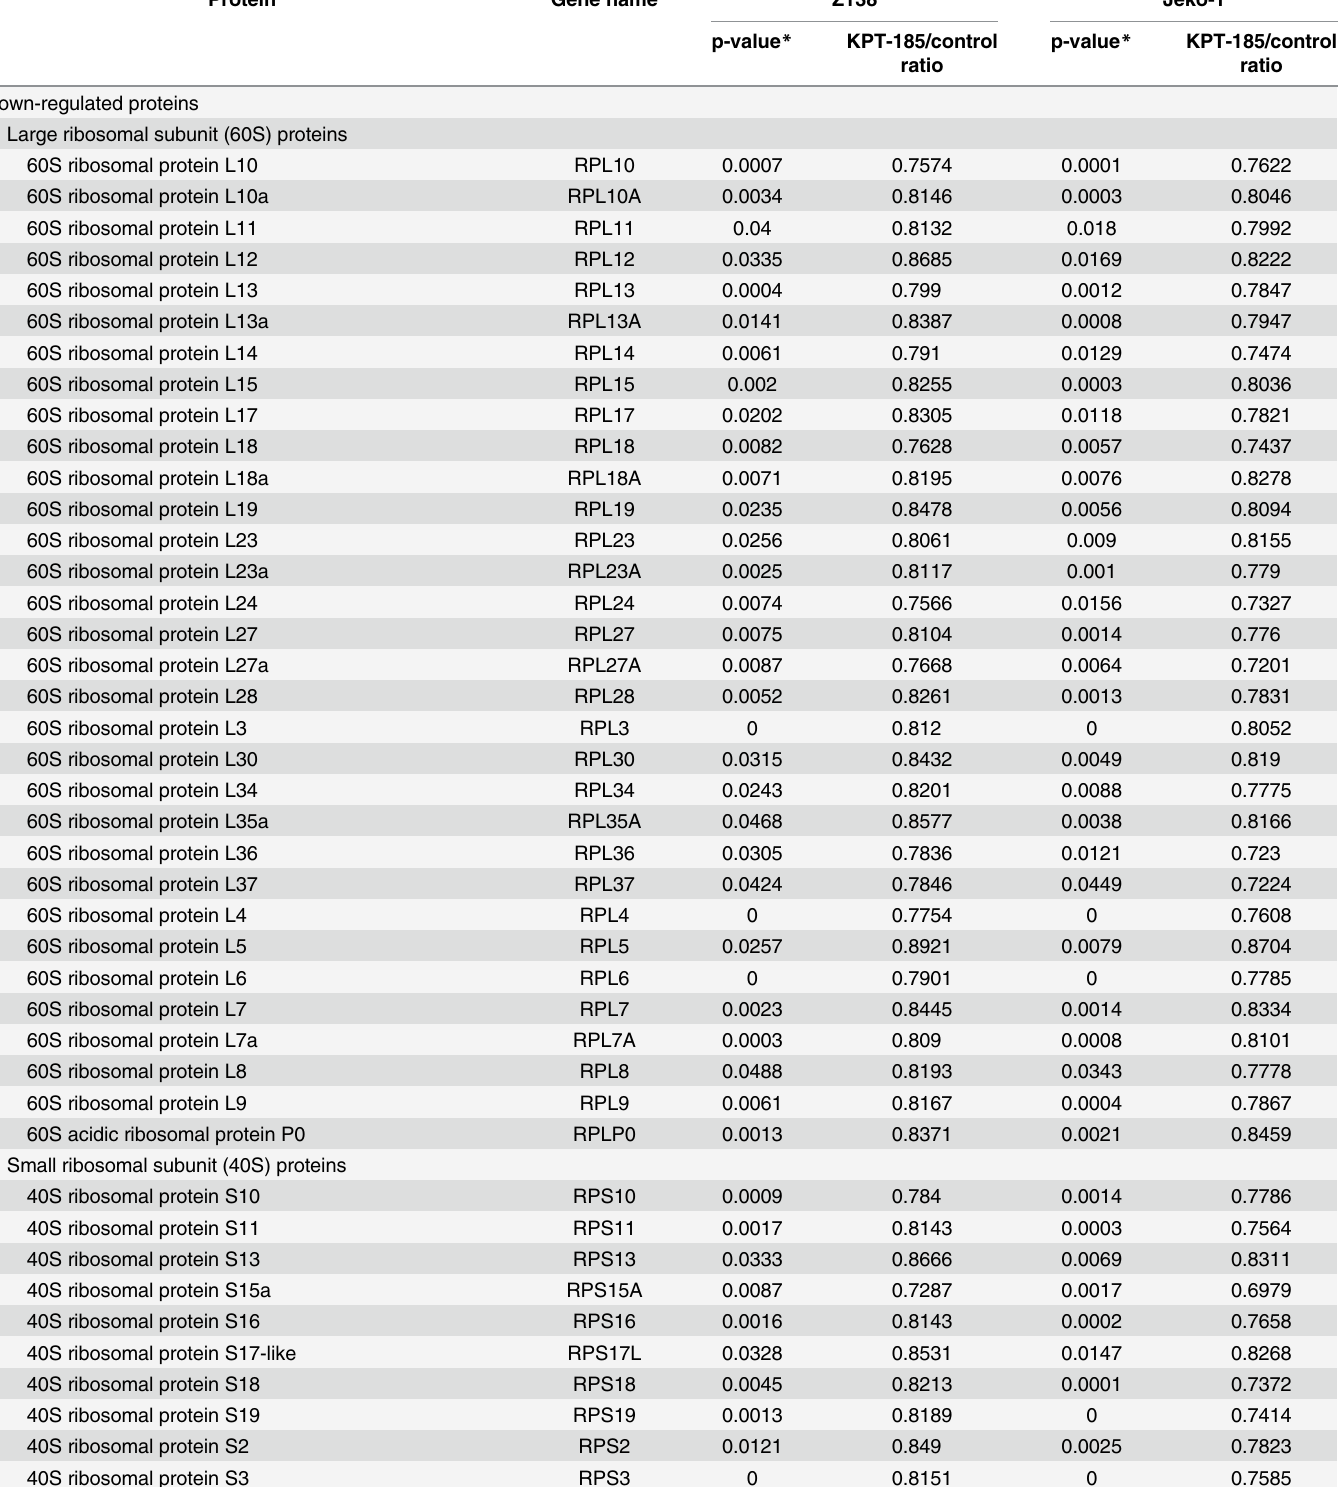
Table 2. Consistent changes in proteins in Z138 and Jeko-1 cells detected by iTRAQ; after KPT185